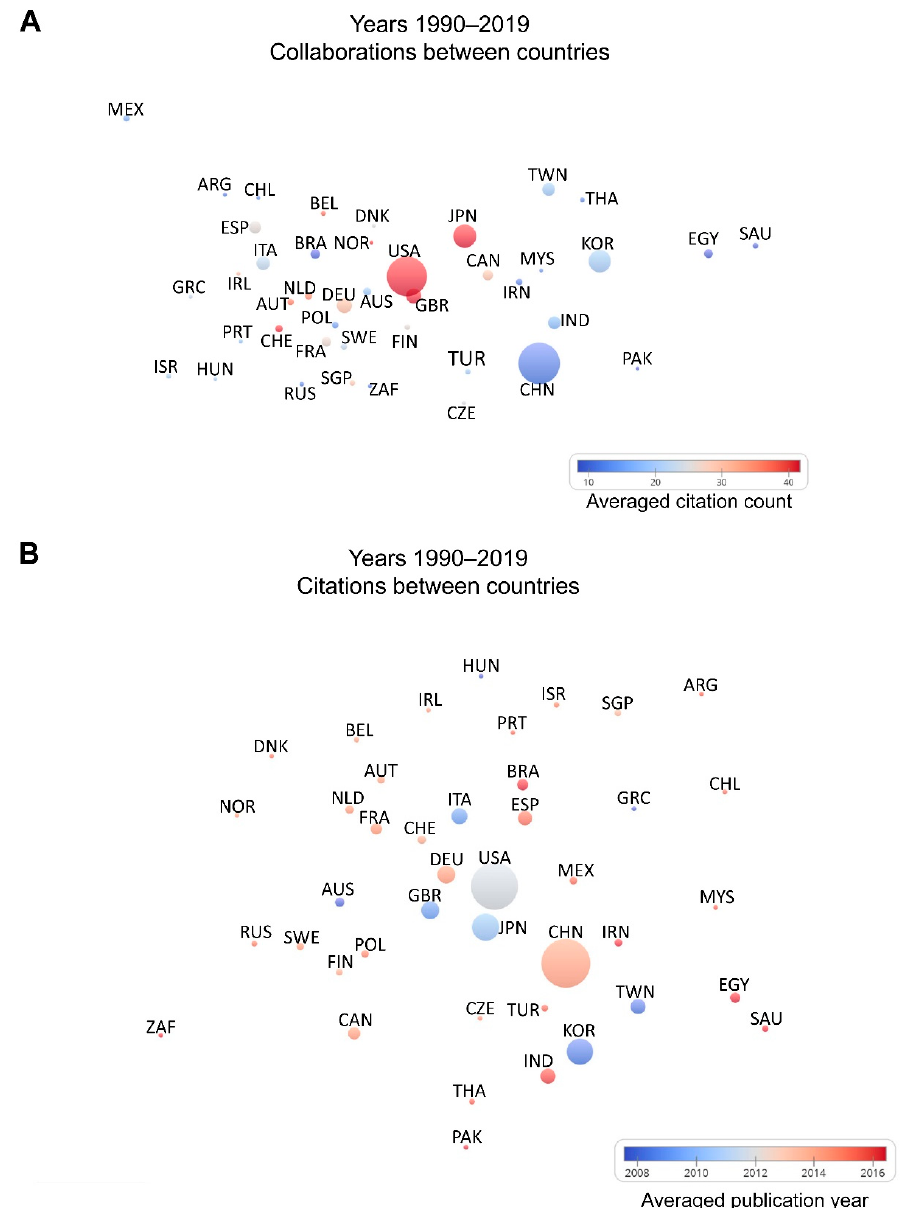
Figure 8. Country term maps for years 1990–2019. ( A ) Bubble map showing collaborations between countries on Nrf2-related research. Countries with at least 20 publications are included. The